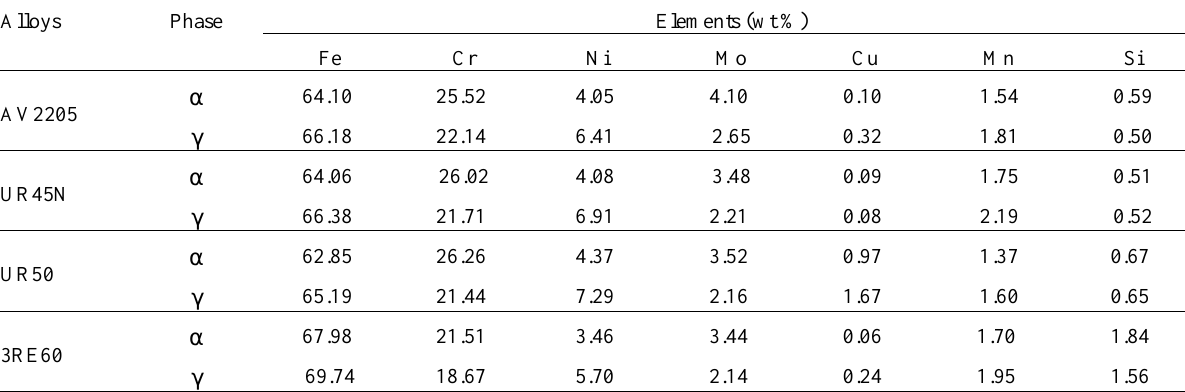
Table 5. The chemical composition of γ and α phases in the solution annealed alloys.